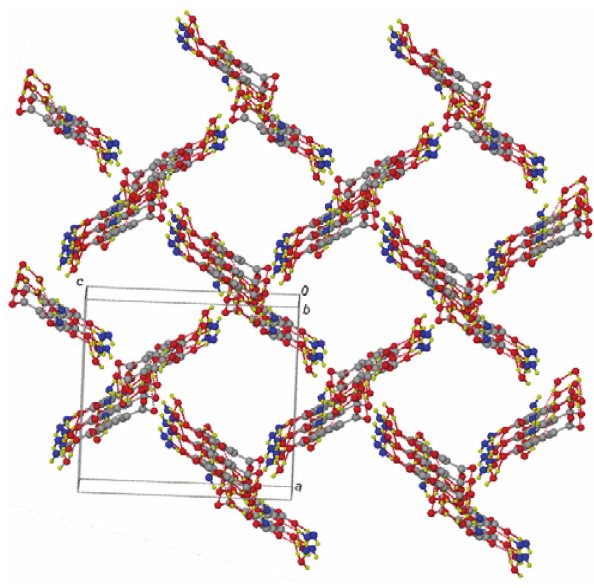
Figure 2 3D structure of compound 1 .